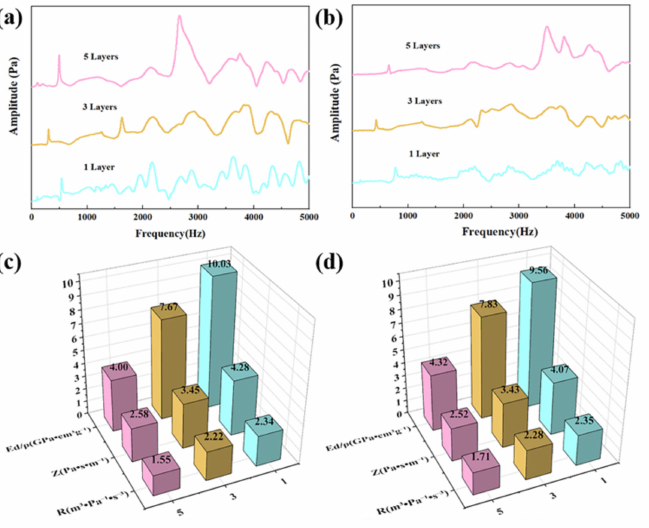
Figure 5. Frequency spectra of composites with different number of layers: ( a ) hemp; ( b ) ramie. Acoustic vibration performance of composites with different layers: ( c ) hemp; ( d )